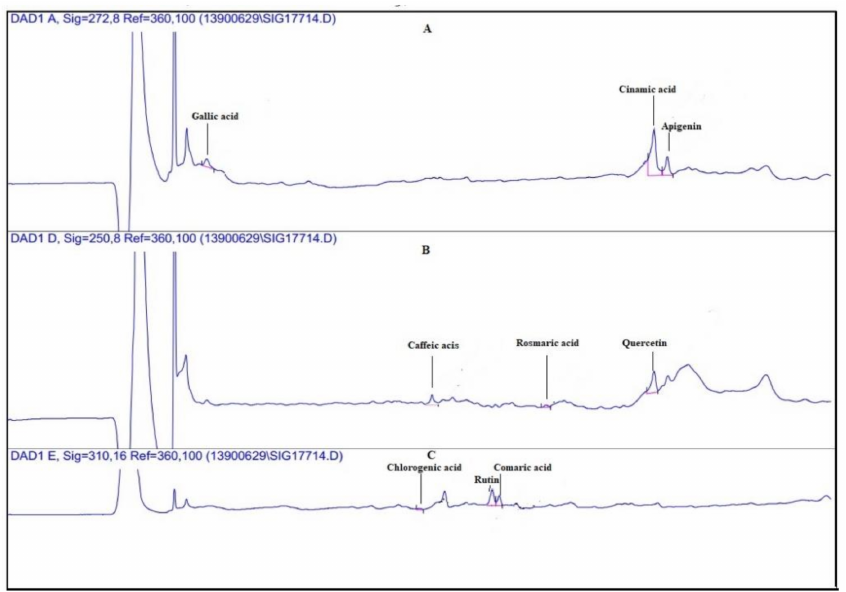
Figure 3. The diagram of identifying the phenolic compounds using the HPLC method at three wavelengths of ( A ) 272 nm, ( B ) 250 nm, and ( C ) 310 nm.